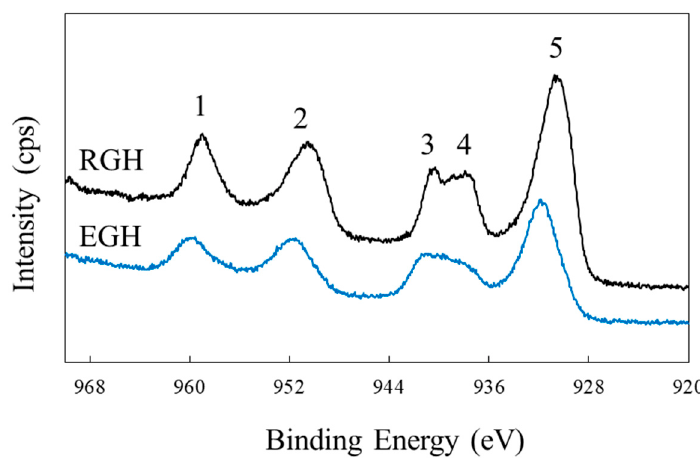
Figure 5. The surface element analysis of the precipitated Cu after reaction with reagent-grade hypochlorite (RGH) and electro-generated hypochlorite (EGH) using XPS.